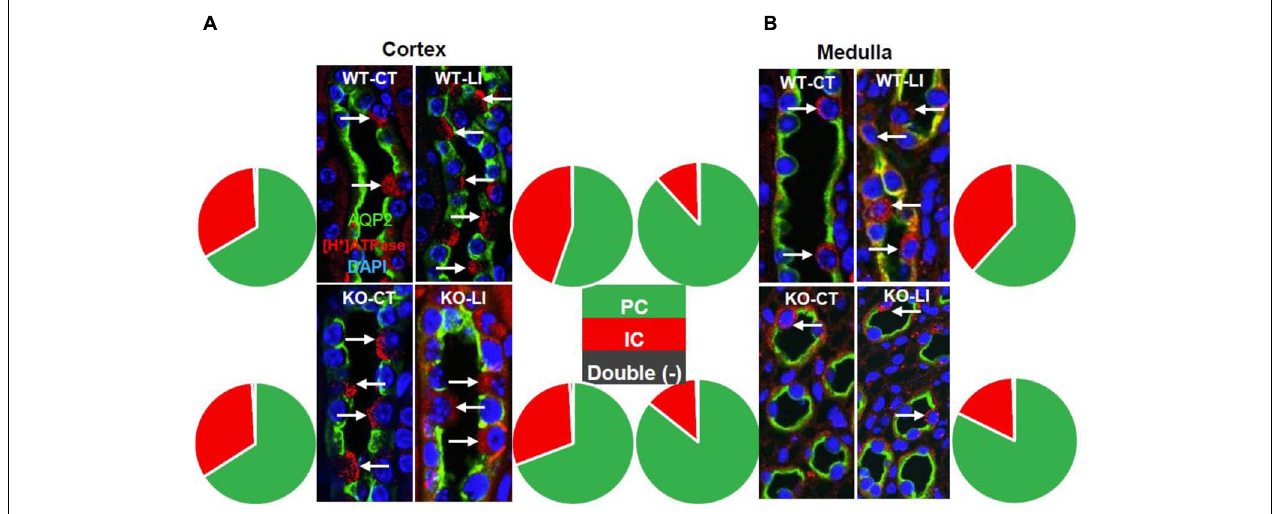
FIGURE 12 | Representative images and summary of the confocal immunofluorescence analysis of chronic Li treatment-induced changes in cortical (A) and medullary collecting duct (B) cell composition in wild type (WT) or P2Y 2 knockout (KO) control (CT) or lithium-fed (LI) mice. AQP2 (green) and [H + ]-ATPase (red) double-immunolabeling was used to identify the principal (PC) and intercalated (IC) cells of the collecting duct, respectively. Nuclei are stained with DAPI. Note the significantly increased number of ICs in lithium-treated wild type mice in both cortex and medulla, but only a blunted response in the knockout mice, as illustrated by pie charts. A detectable, but negligible fraction of cells (0.2–0.9%) were stained double negative (black slice in pie charts). For mean ± SE of percent changes and statistical significance by one-way ANOVA refer to Table 1 . For the results of the two-way ANOVA refer to Table 2 .